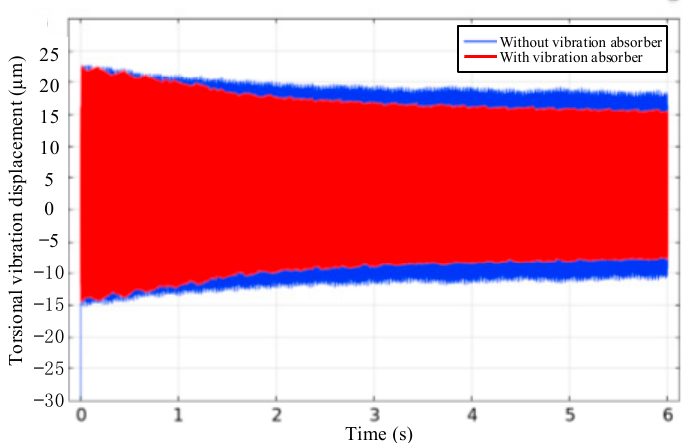
Figure 11. Torsional vibration displacement under periodic excitation. The initial torsional vibration amplitude of the gear system is 37 μ m. Without the vibration absorber, the torsional vibration amplitude of the gear is reduced to 32 μ m within 2 s. Meanwhile, the torsional vibration amplitude for the gear system with an in- ternal resonance vibration absorber is reduced to 27.5 μ m within 2 s, 14.1% less than that without the vibration absorber. Within 6 s, the torsional vibration amplitude without the vibration absorber is reduced to 30.5 μ m, while the torsional vibration amplitude with the vibration absorber is reduced to 22 μ m, i.e., 27.9% less than that without the vibration absorber. Therefore, the internal resonance-based method can effectively decrease the tor- sional vibration of the gear system.